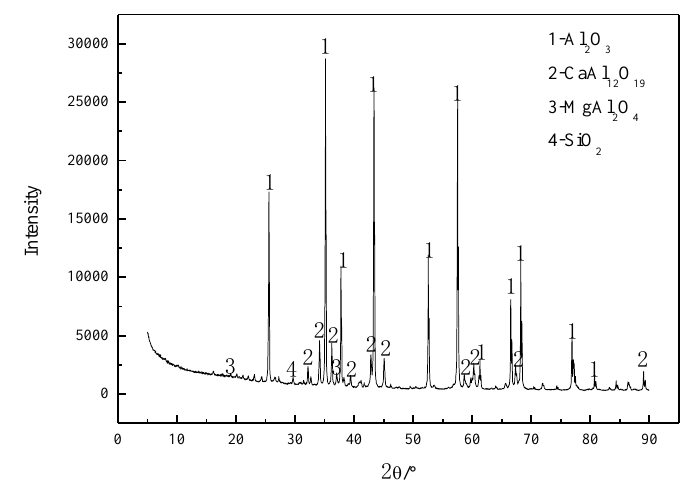
Figure 2. XRD analysis of alumina particle.